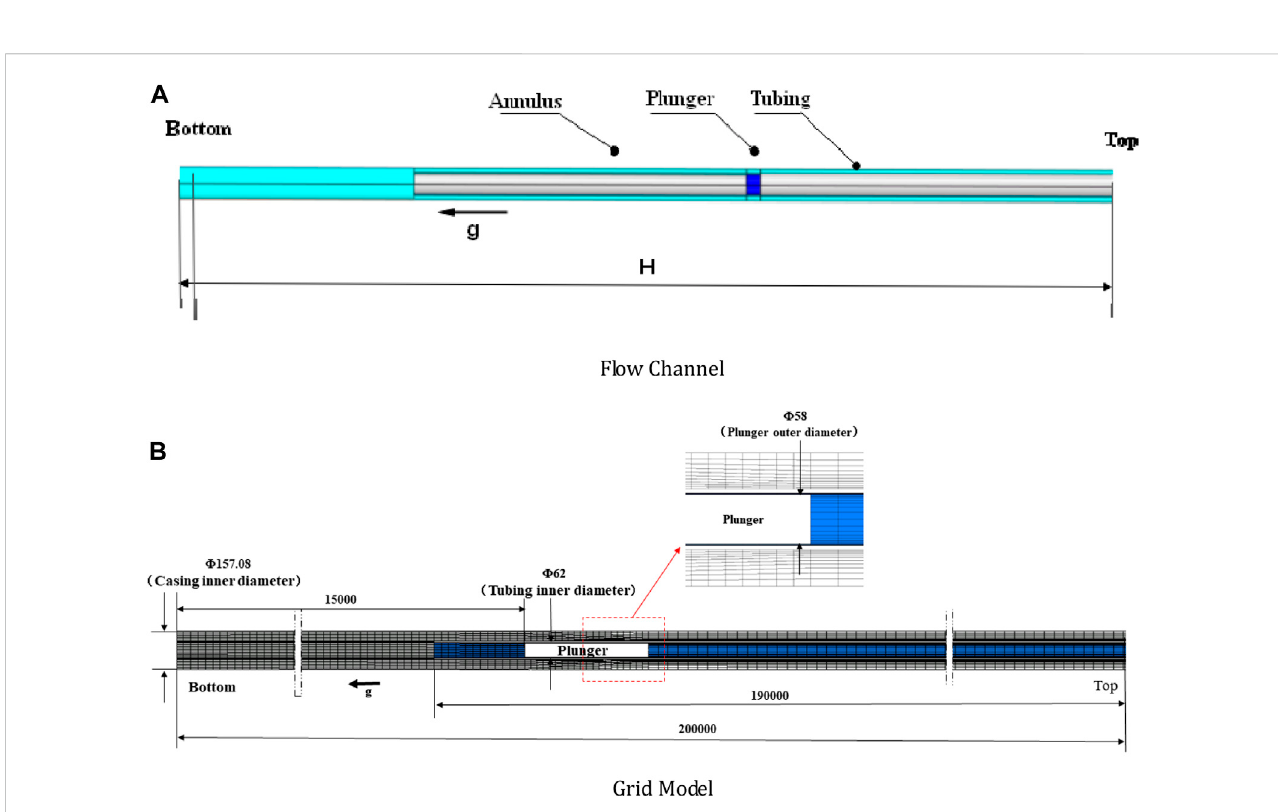
FIGURE 7 CFD model for down-hole plunger gas lift. (A) . Flow channel model (B) . Grid